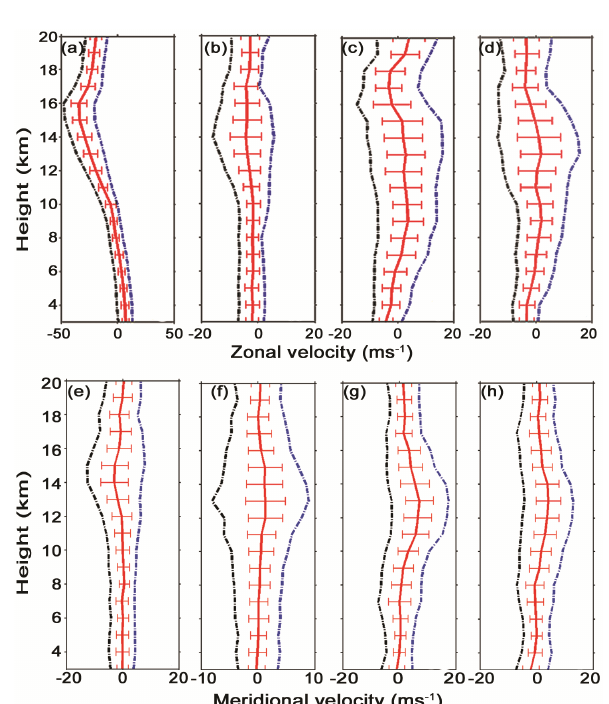
Figure 2. The seasonal mean (a–d) zonal and (e–h) meridional winds (solid line) for southwest monsoon, northeast monsoon, win- ter and summer seasons, respectively. Also shown are the standard deviation as error bars and the range of wind velocities (minimum and maximum winds as dash dot lines) within the